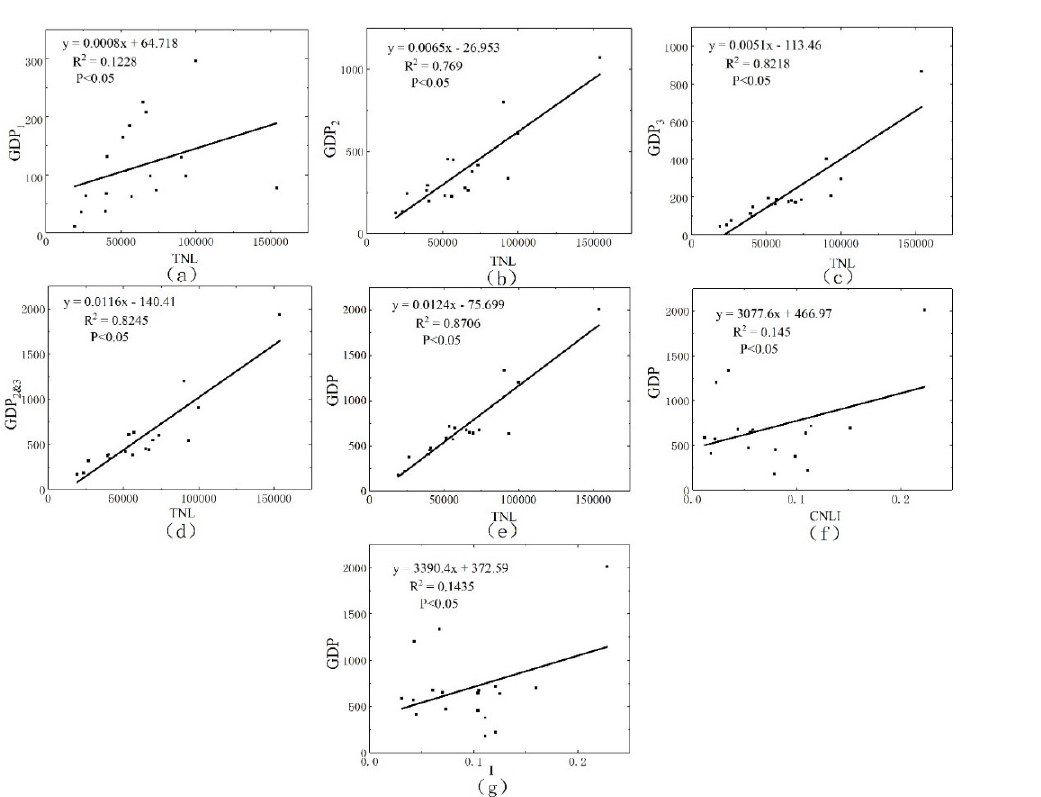
Fig.2 Light index and GDP regression analysis in 2006